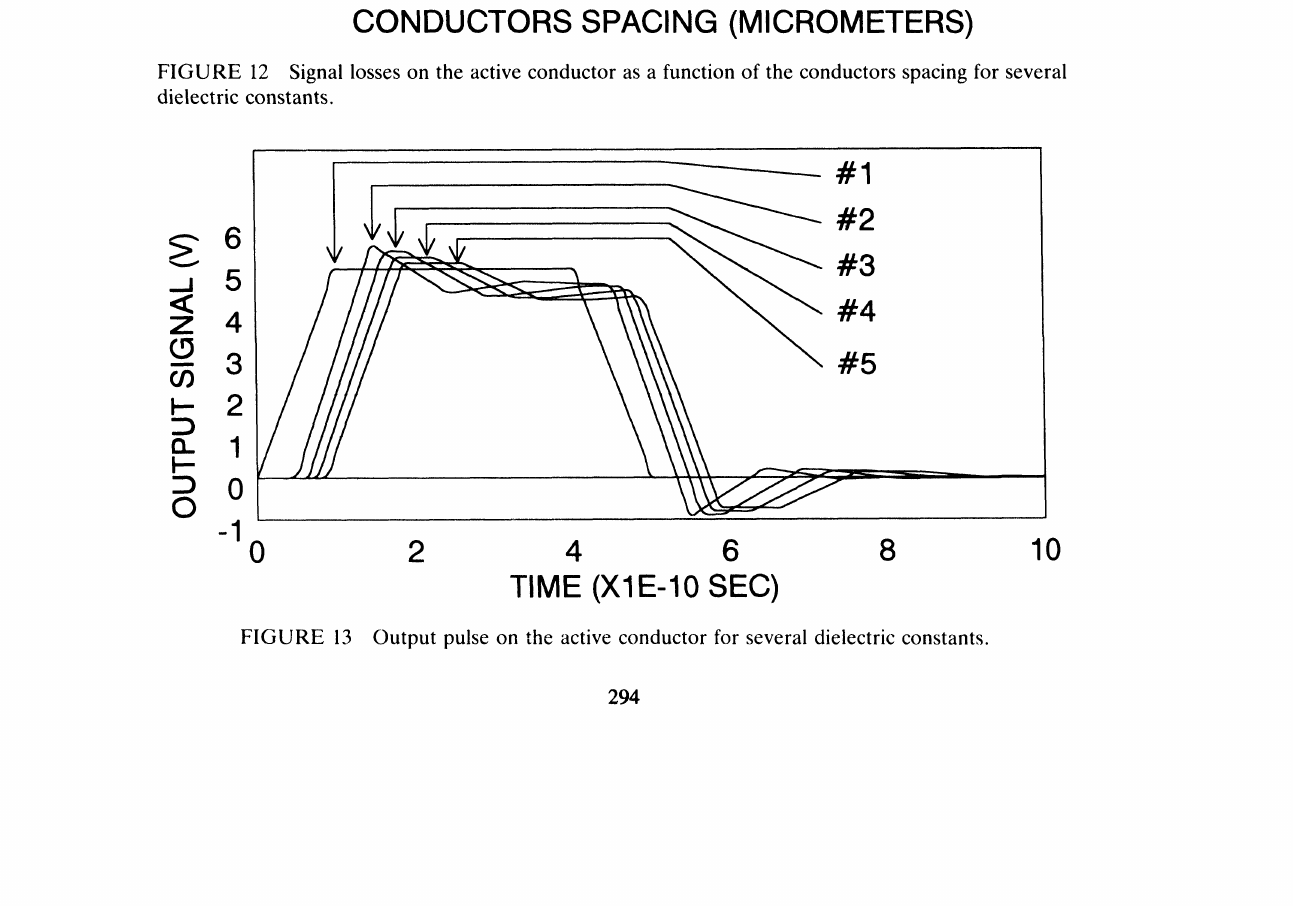
FIGURE 11 Crosstalk pulse for several dielectric constants (spacing 30 m).